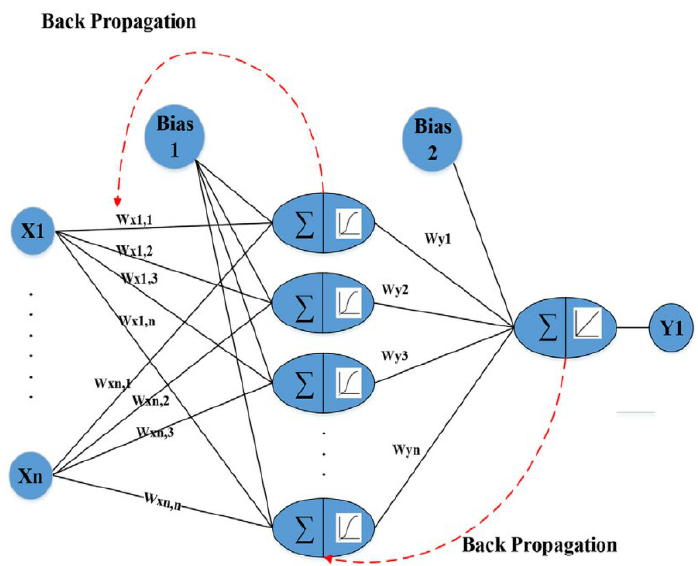
Figure 2. MLP architecture based on BP algorithm.